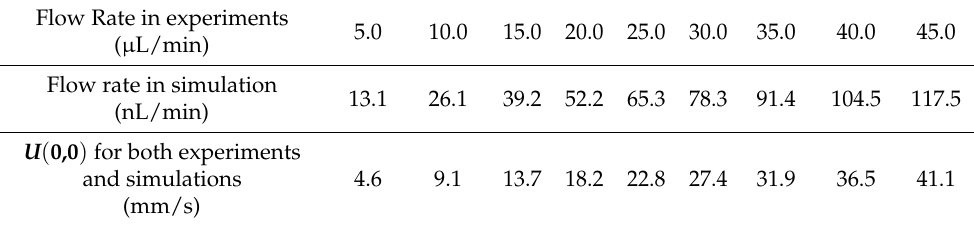
Table 1. Flow conditions in experiments and numerical